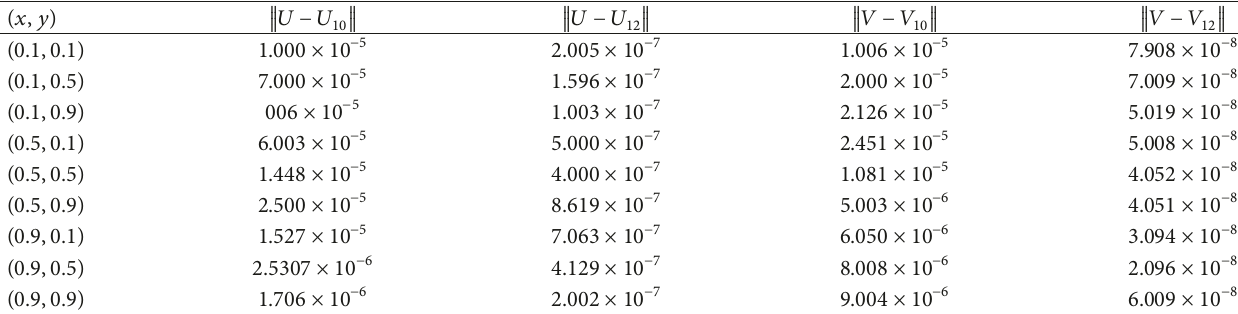
Table 3: Maximum absolute error at 𝐾 = 10, 12 of 𝑈(𝑥,𝑦) and 𝑉(𝑥, 𝑦) using various values of (𝑥,𝑦) for Problem 2.